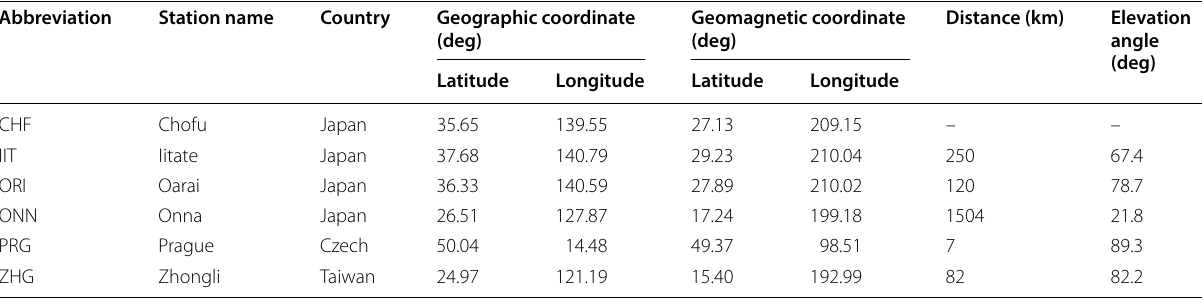
Table 1 List of HF Doppler sounders in Japan, Czech Republic and Republic of